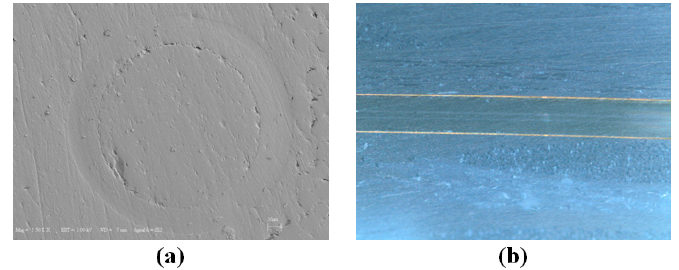
Figure 8. ( a ) Perpendicular and ( b ) longitudinal cross-sections of optical fibres around FBG